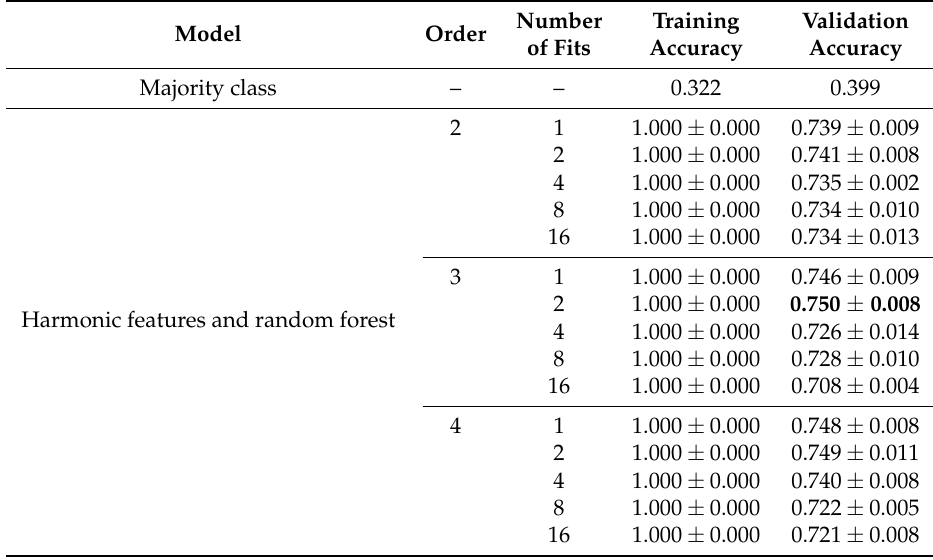
Table A4. Harmonics hyperparameter tuning. Grid search was performed to find the best pair of hyperparameters: the number of cosine and sine terms (order) and number of recursive fits. Each combination of hyperparameters was trained with 10 random bootstrapped training sets to obtain error bars (shown for 1 standard deviation). Random forest hyperparameters were kept at default based on previous work [36], except number of trees was increased to 500.